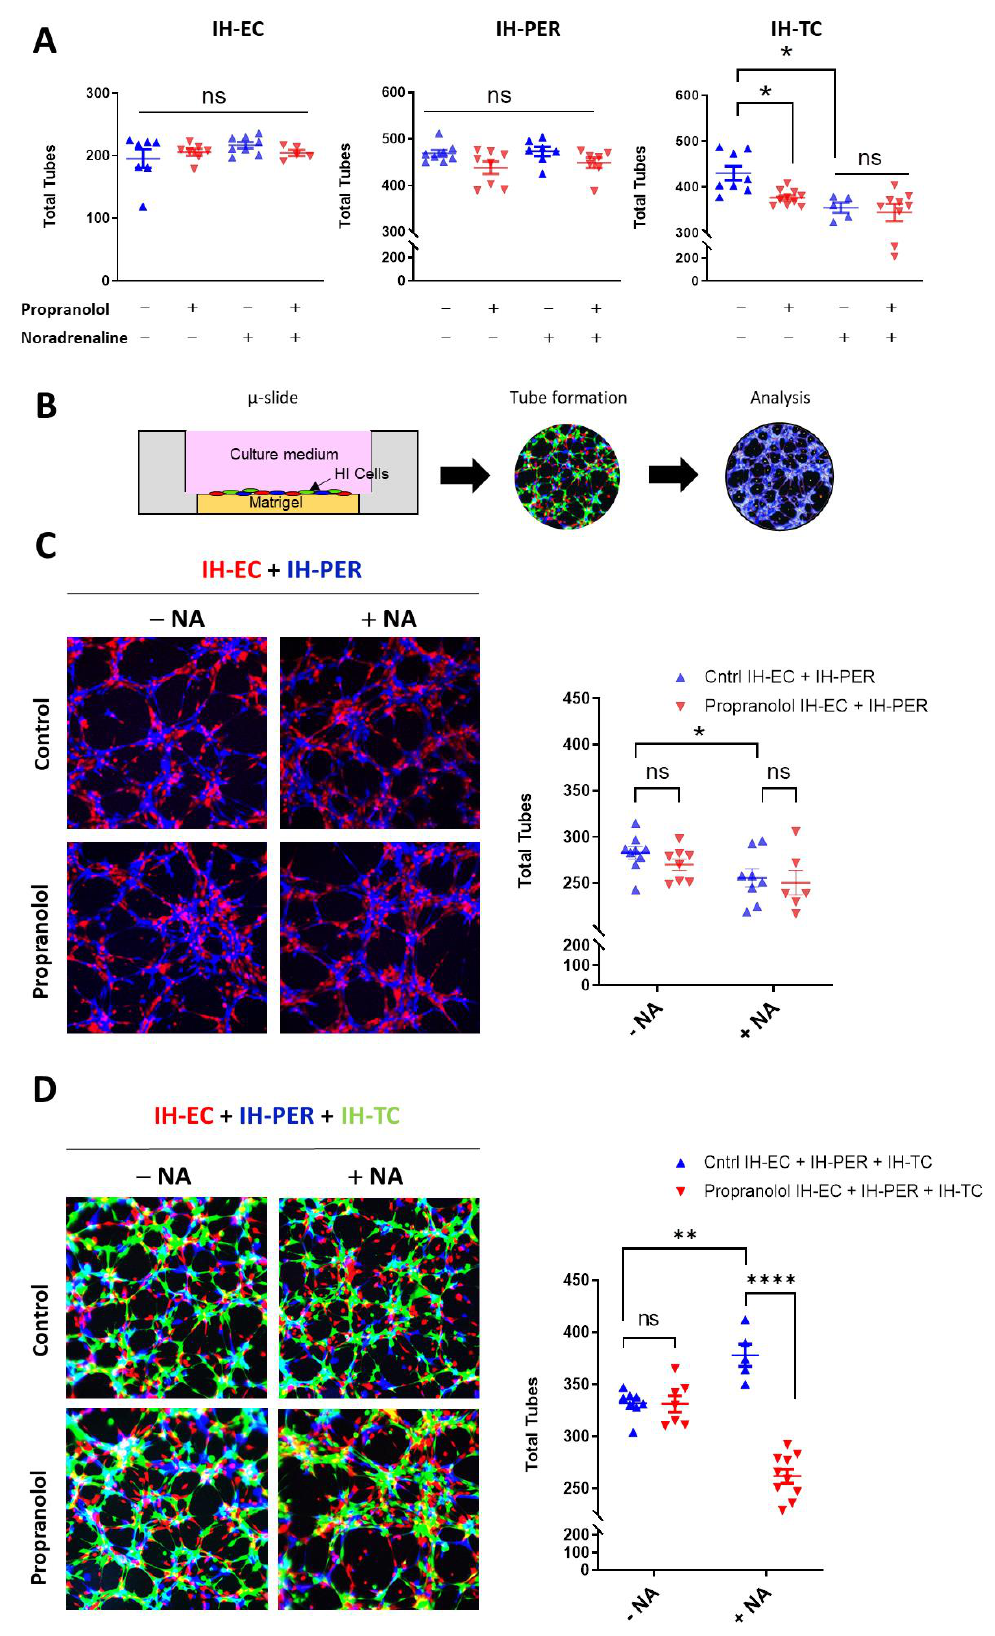
Figure 4. A threshold level of NA and a crosstalk between EC, PER and TC are the prerequisite for detecting the antiangiogenic effect of propranolol on our in vitro Matrigel tube formation